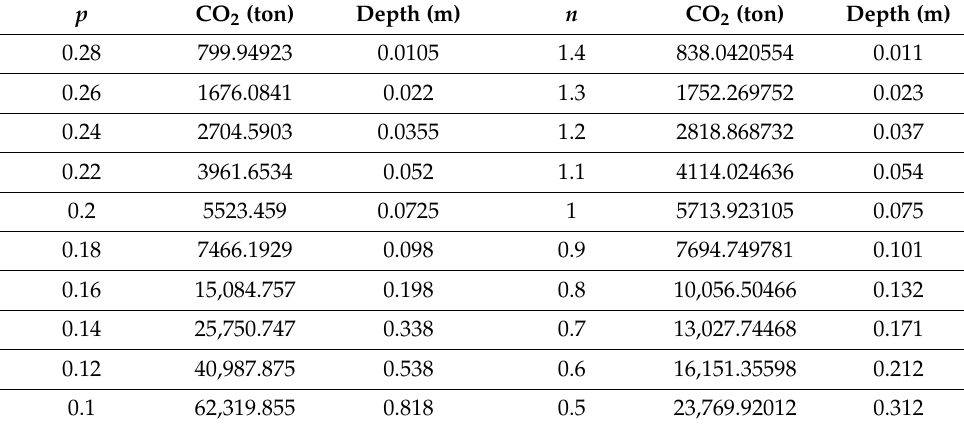
Table 2. Relationship between element content and carbon dioxide emission in